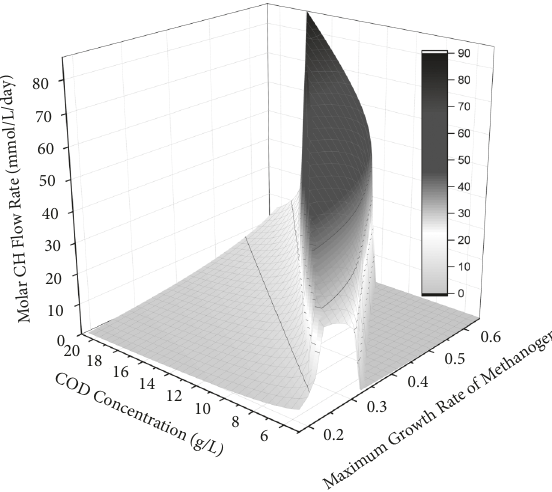
Figure 1: Steady-state profile for the methane flow rate.